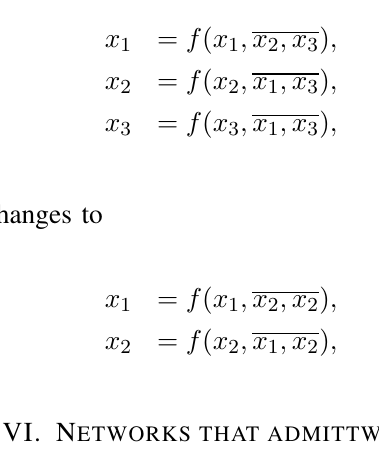
Fig. 6. two cell bidirectional ring